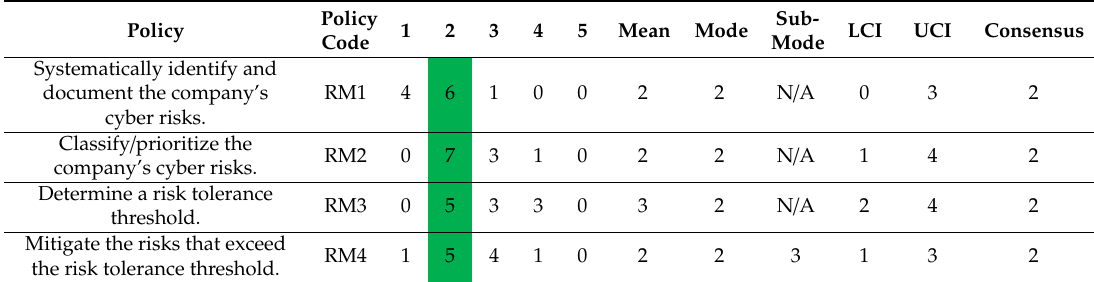
Table 5. Risk management policies’ starting